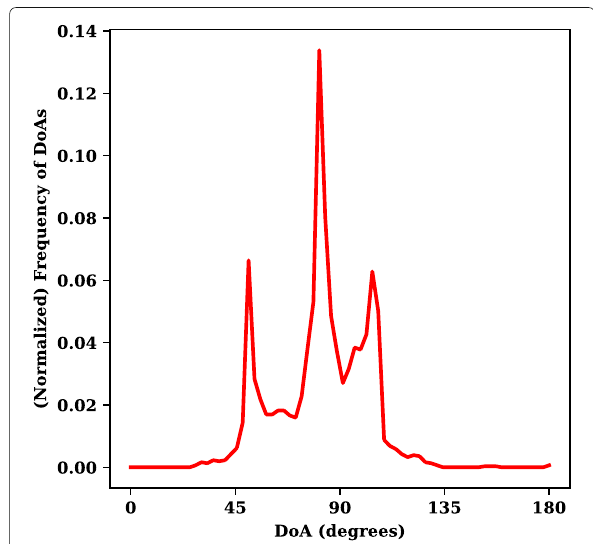
Fig. 4 Histogram of SRP-NMF (CNMF) on a mixture of 3 sources taken from the SiSEC database dev1_male3_liverec_250ms_5cm_ mix.wav , with β = 60 and D T = 35. The ground truth DoAs are 50 ◦ ,80 ◦ and 105 ◦ . The 3 peaks are clearly visible now